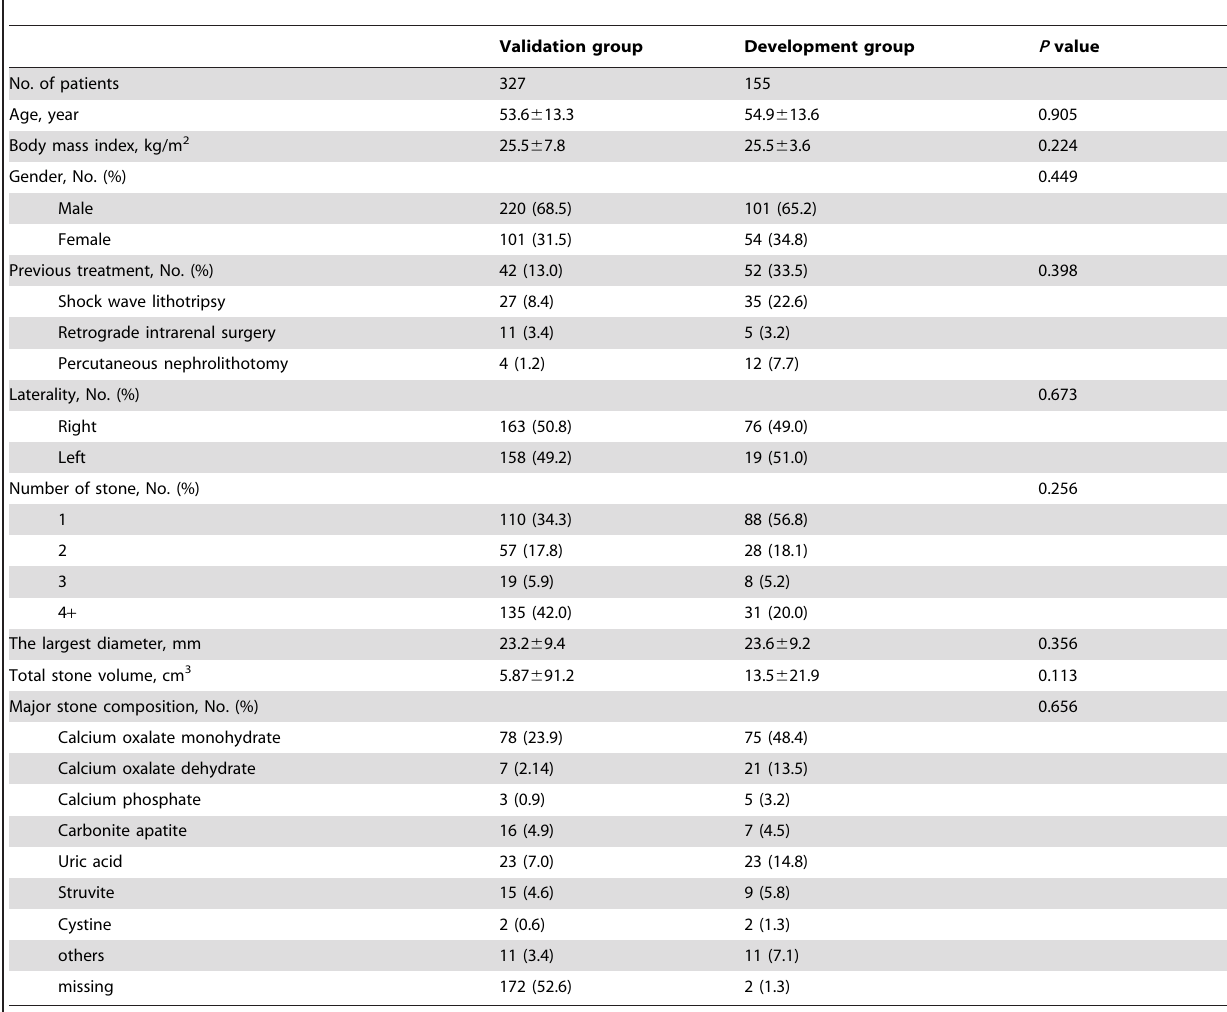
Table 1. Comparison of patients’ demographics between the validation data and the original development data of S-ReSC scoring system.